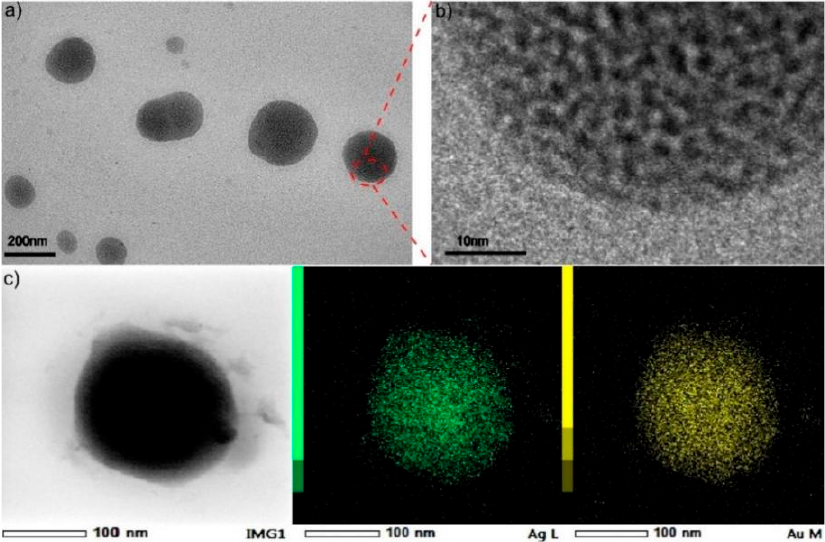
Figure 2. ( a )TEM images of Au@ Ag NCs by using PVP as soft template; ( b )HR-TEM images and ( c ) the elemental mapping images of Au, Ag in assembled Au@ Ag NCs.